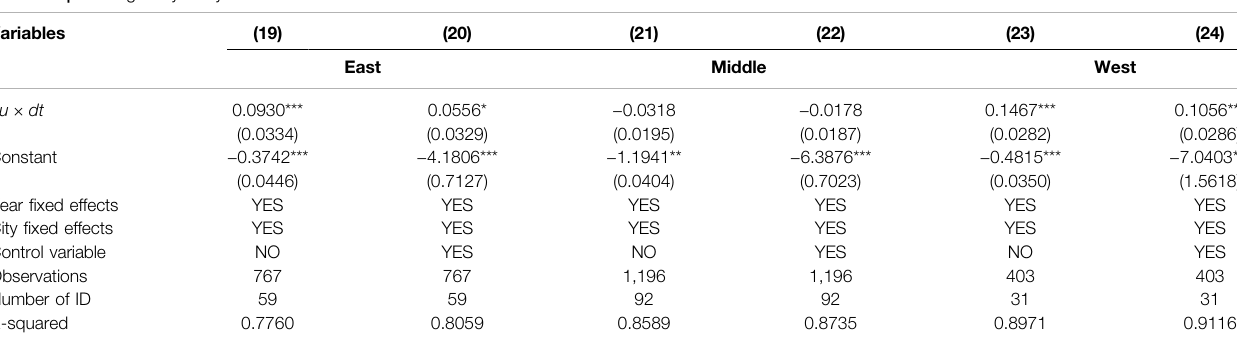
TABLE 7 | Heterogeneity analysis